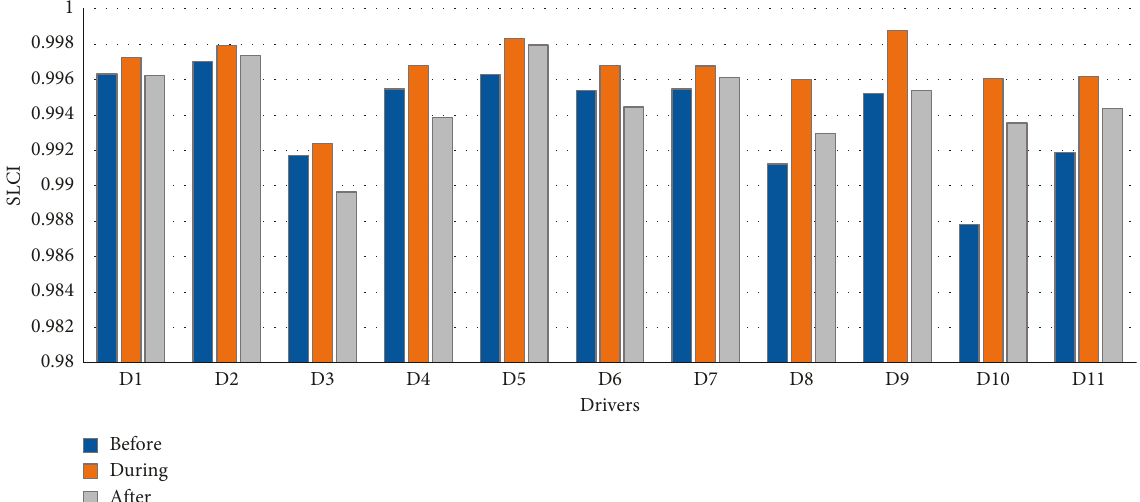
Figure 6: Speed limit compliance index (SLCI) for all 11 drivers regarding to three periods of study and for the segment III.